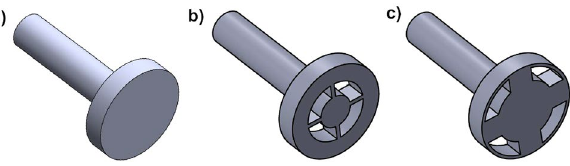
Figure 3. Schematic of the bluff bodies. ( a ) Baseline bluff body without slots. ( b ) Bluff body with slots near the center—inner slot bluff body (IS). ( c ) Bluff body with slots near the edge of the circle—outer slot bluff body (OS). Both slotted bluff bodies have the same area of slots.